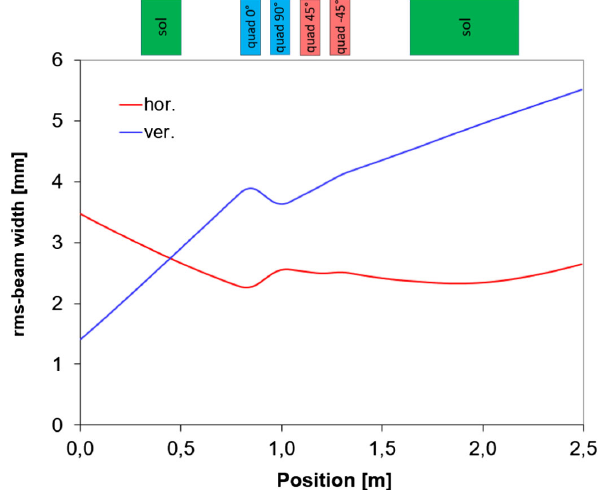
FIG. 5. Horizontal (red) and vertical (blue) rms-envelope along the beam line as obtained from tracking calculations.